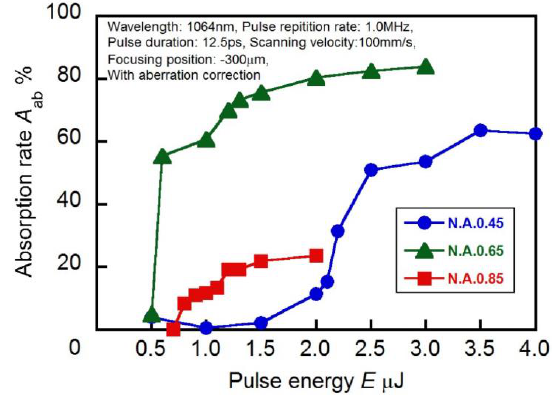
Figure 12. Influence of numerical aperture on absorption rate.